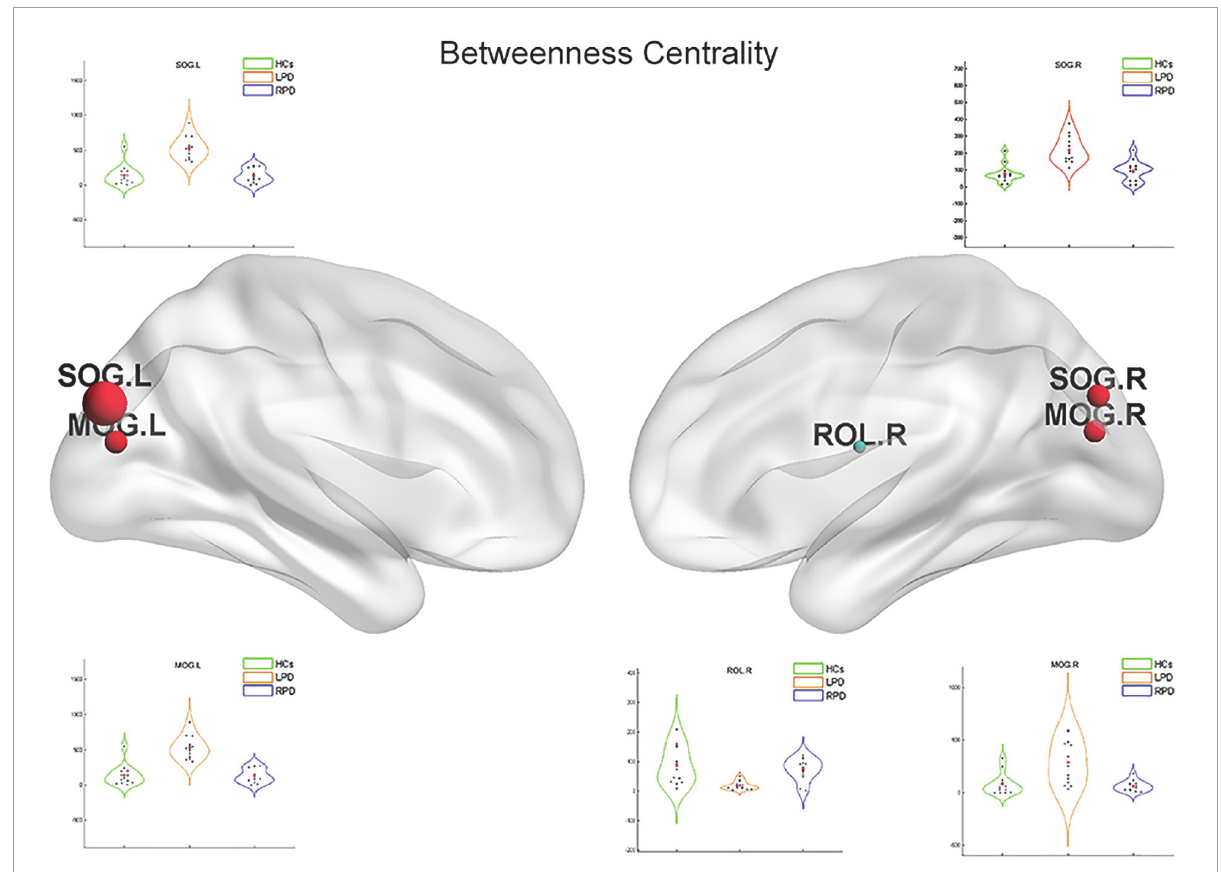
FIGURE2 Left-onset PD (LPD) patients showed increased betweenness centrality (BC) in the bilateral superior occipital gyrus and bilateral middle occipital gyrus as well as decreased BC in the right Rolandic operculum.